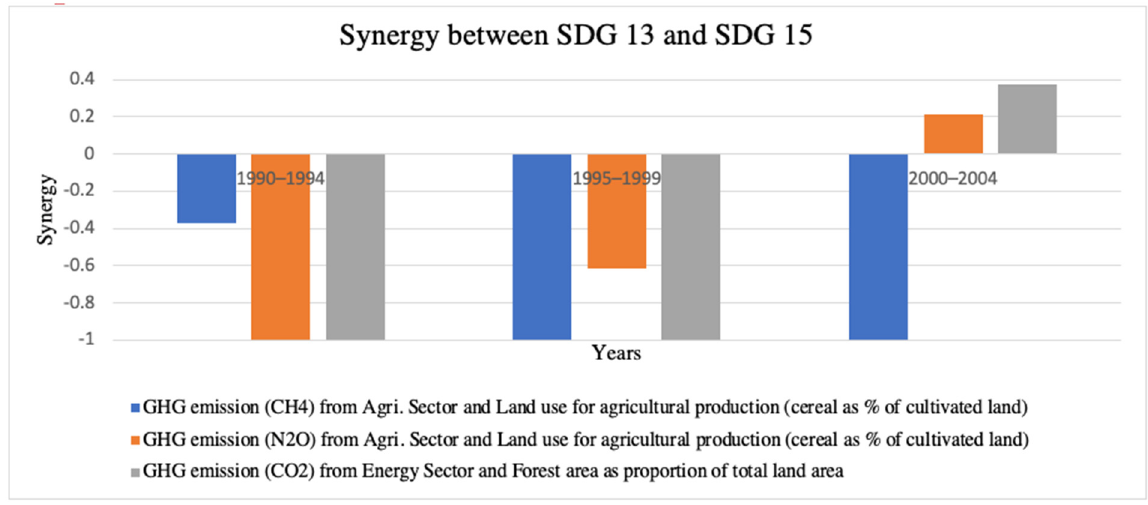
Figure 18. Synergy Among SDG 13 and SDG